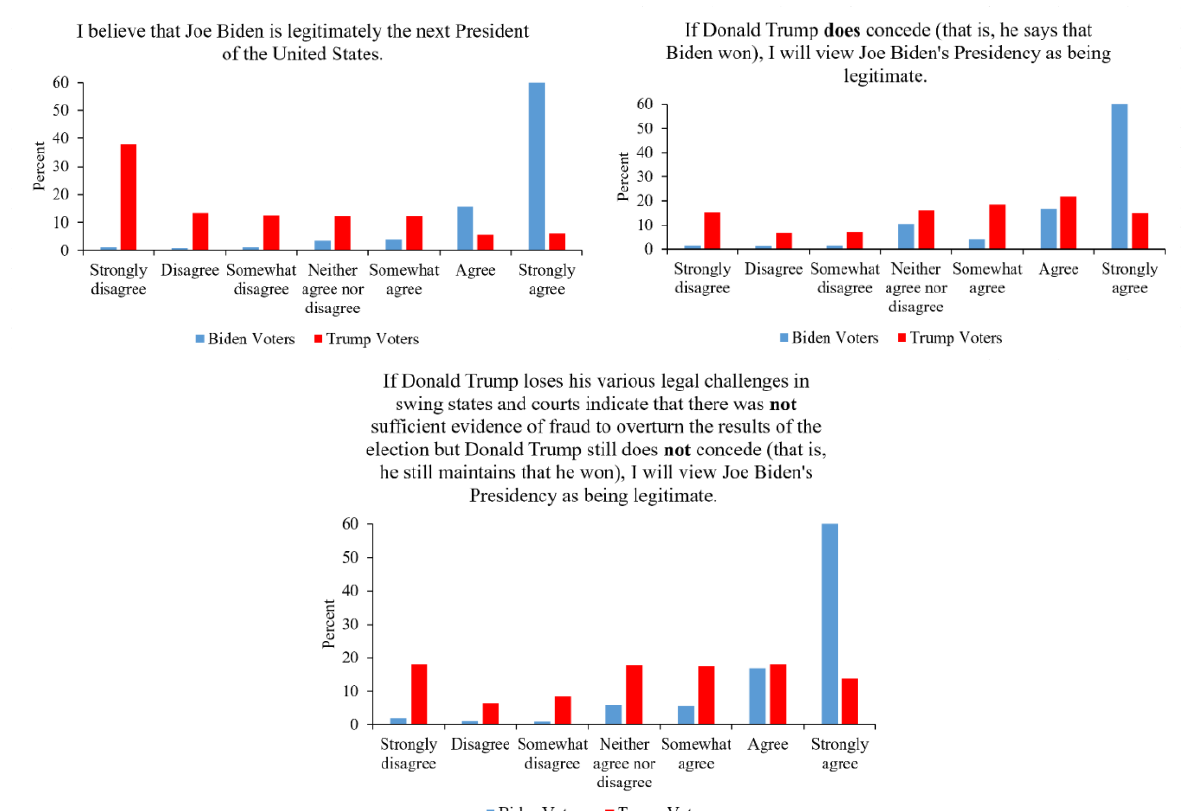
Figure 2. Belief in who won the election . Majorities of Trump voters believe him to have won the election, whereas Biden voters are confident that Biden won the election. Participants were asked “Who do you believe won the 2020 Presidential Election?” (left panel) and responded on a scale from 0 (Definitel y Joe Biden) to 100 (Definitely Donald Trump), with 50 indicating “It’s a toss-up. ” This was counterbalanced across participants so that half of the time 0 = Definitely Donald Trump (these were converted to be the opposite for ease of reporting). Participants were also asked (right panel) “Whether or not they win the electoral college (and therefore the election), who do you believe got the most total votes (i.e., won the popular vote) in the 2020 Presidential Election?” or “Whether or not they win the electoral college (and therefore the election), who do you believe got the most total legal votes (i.e., won the popular vote excluding any fraudulent ballots) in the 2020 Presidential Election?” – including the word “legal” did not have a n impact on the results among Trump voters, t(1020) = .837, p = .403, or Biden voters, t(602) = 1.56, p = .119, and thus we collapsed across wordings in the figure. The order of the response scale was also counterbalanced across participants for the voting question.